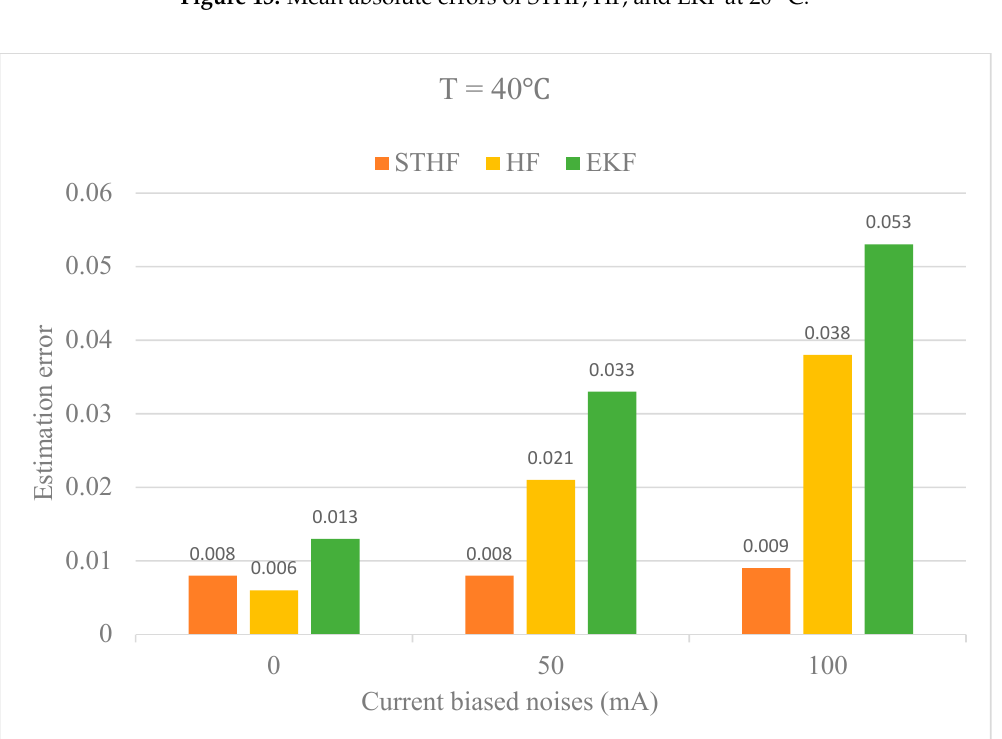
Figure 14. Mean absolute errors of STHF, HF, and EKF at 40 °C.